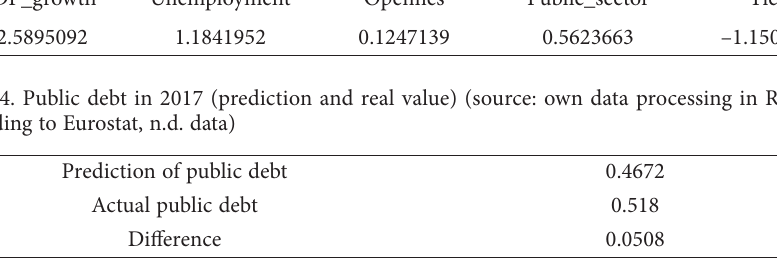
Table 3. Values of indicators in linear regression model (source: own data processing in R program) GDP_growth